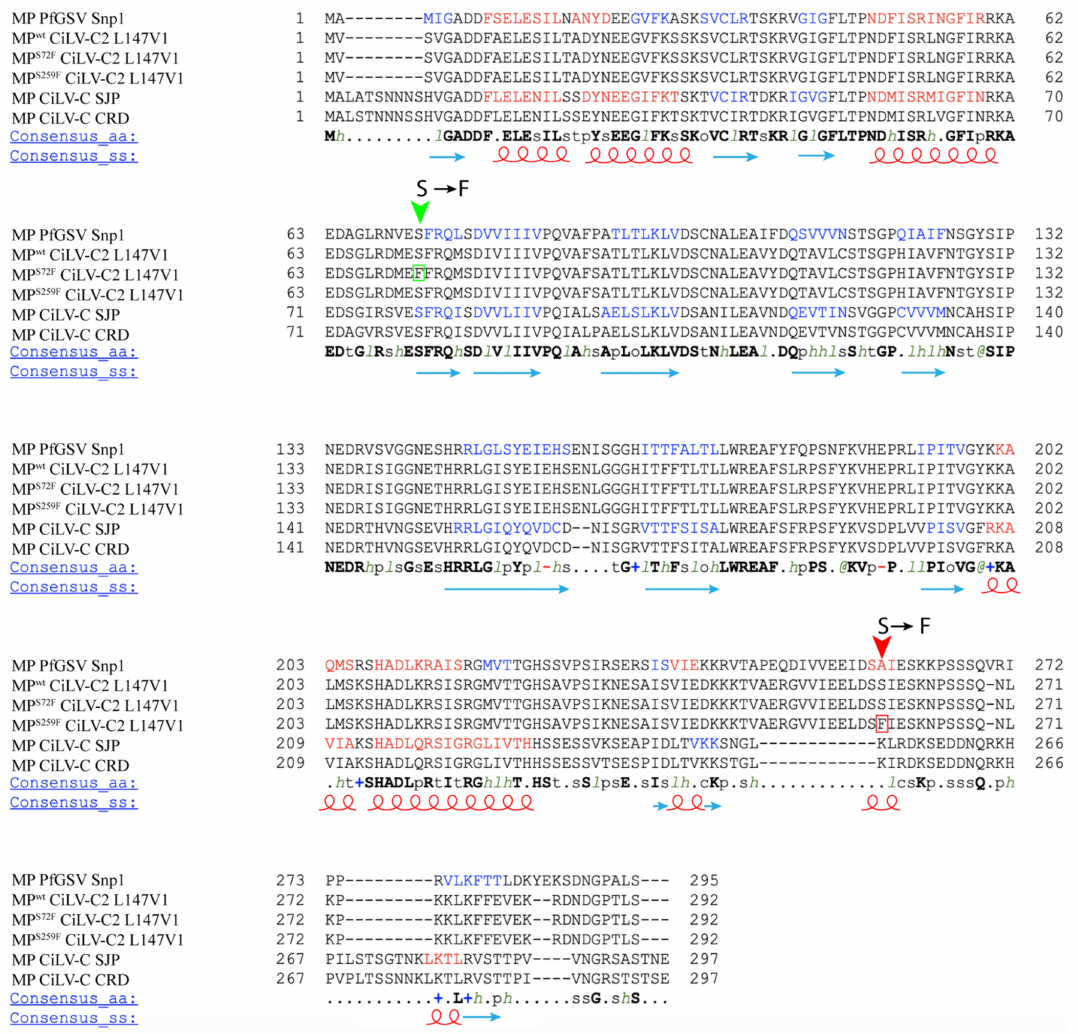
Figure 6. Alignment of the MPs of CiLV-C strain CRD, CiLV-C strain SJP, CiLV-C2 strain L147V1, and passion fruit green spot virus (PfGSV) strain Snp1 using the PROMALS3D program. The annotated secondary structural features were